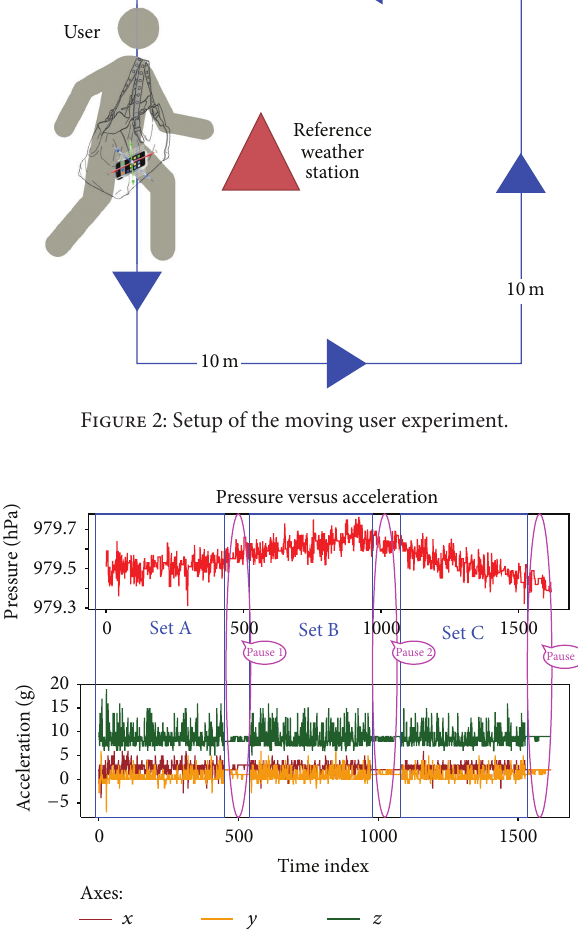
Table 2: Uncertainty calculation results based on the Vaisala WXT520.